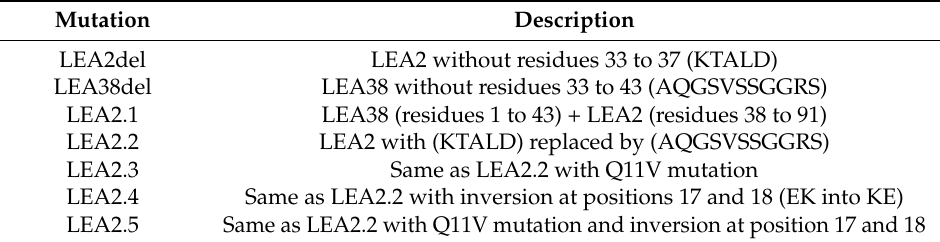
Table 1. Description of the different mutated protein constructs.